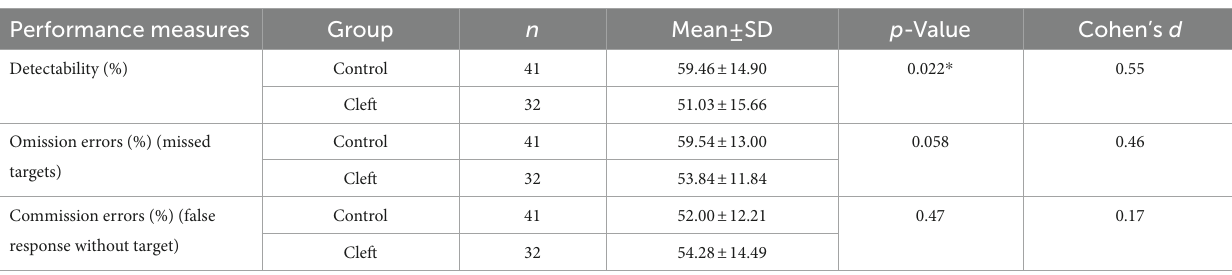
TABLE 2 Results of the CPT (continuous performance